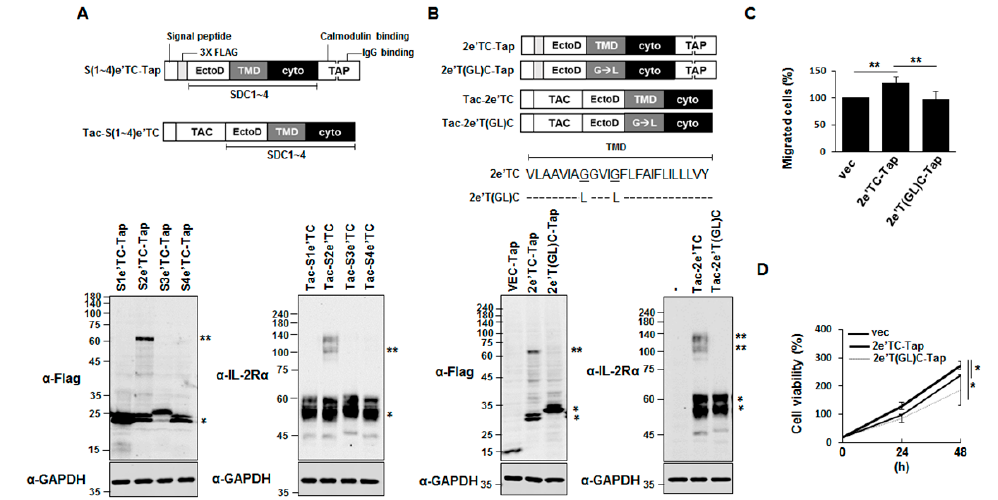
Figure 3. Syndecan ‐ 2 transmembrane domain induces SDS ‐ resistant dimer formation of chimeric proteins. ( A ) Schematics of syndecan ‐ TAP and Tac ‐ syndecan constructs containing four amino acid residues of the extracellular domain, TMD, and cytoplasmic domain of each syndecan. The number indicates the syndecan family member (top). HEK293T cells were transiently transfected with the indicated constructs. Total cell lysates were prepared with RIPA buffer containing 2.5% SDS, separated on SDS ‐ PAGE, and analyzed with Western blotting performed using anti ‐ Flag or anti ‐ IL ‐ 2R α antibodies. Migration positions of SDS ‐ resistant dimers (**) and monomers (*) are in ‐ dicated. ( B ) HEK293T cells were transfected with 2eTC ‐ Tap, 2eT(GL)C ‐ Tap, Tac ‐ 2eTC, or Tac ‐ 2eT(GL)C constructs. Cells were lysed with RIPA buffer containing 2.5% SDS, separated on SDS ‐ PAGE, and analyzed with the indicated antibodies. An antibody against GAPDH was used as a loading control. ( C ) Transwell migration assays were performed using HEK293T cells expressing syndecan ‐ 2 constructs, with 10% FBS applied as a chemoattractant in the lower chamber. Cells were allowed to migrate for 18 h and stained with 0.6% hematoxylin and 0.5% eosin. The migrated cells were counted (right). ( D ) Cells expressing the indicated syndecan ‐ 2 constructs were plated to 96 ‐ well plates and incubated for the indicated periods of time. Proliferated cells were measured by MTT assay. The data shown are representative of three independent experiments. Bars represent average ± standard deviation; * p < 0.05 , ** p < 0.001.